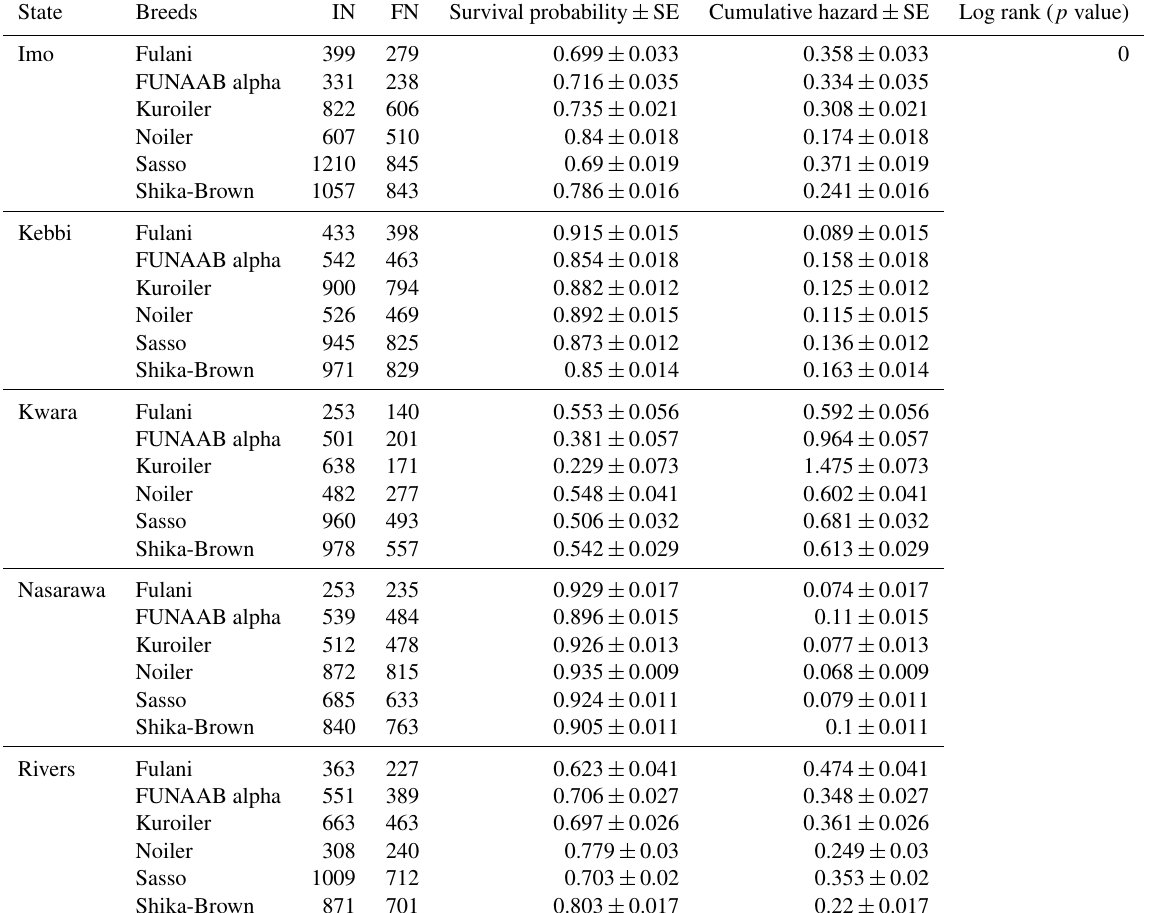
Table 13. Breed by environment interaction on survivability of female birds raised on-farm in ACGG Nigeria project zones (22–70 weeks)